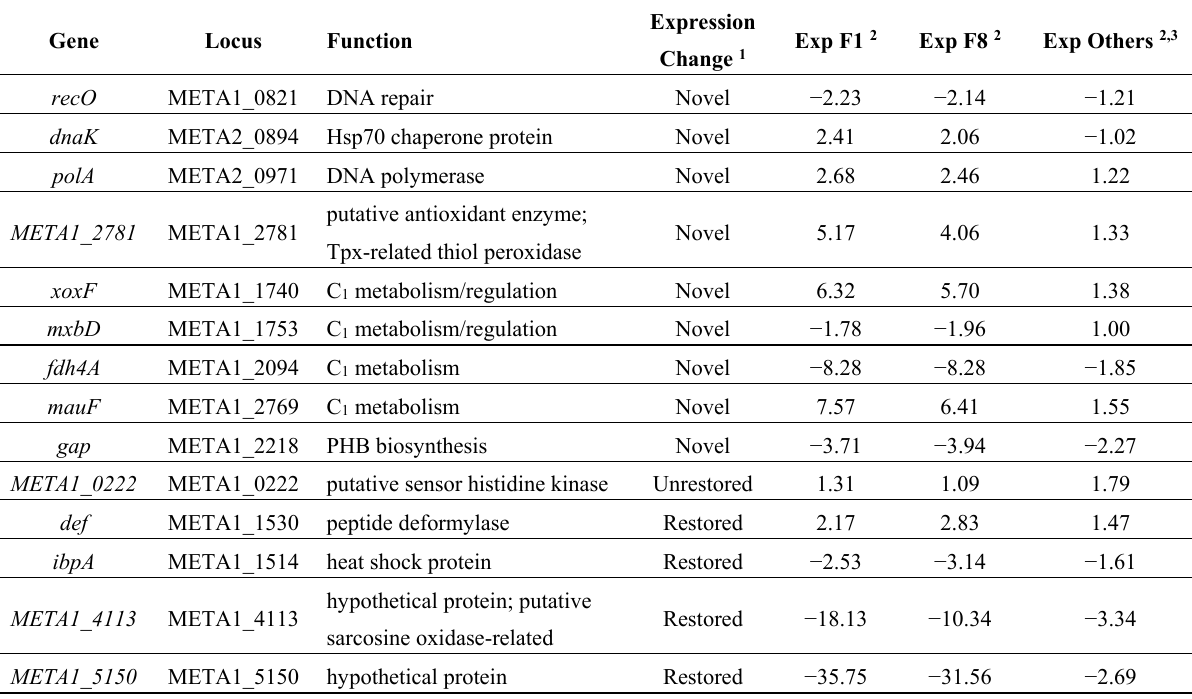
Table 3. Gene expression divergence in strains with rpoA EVO